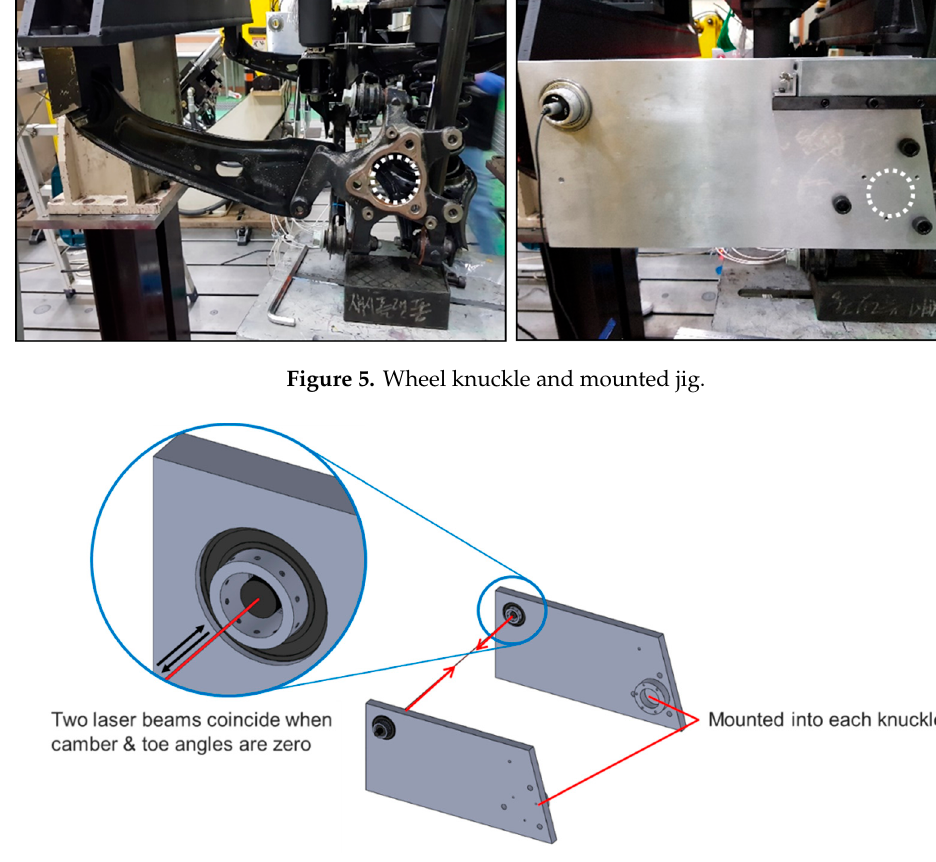
Figure 6. Zero camber and toe angles.